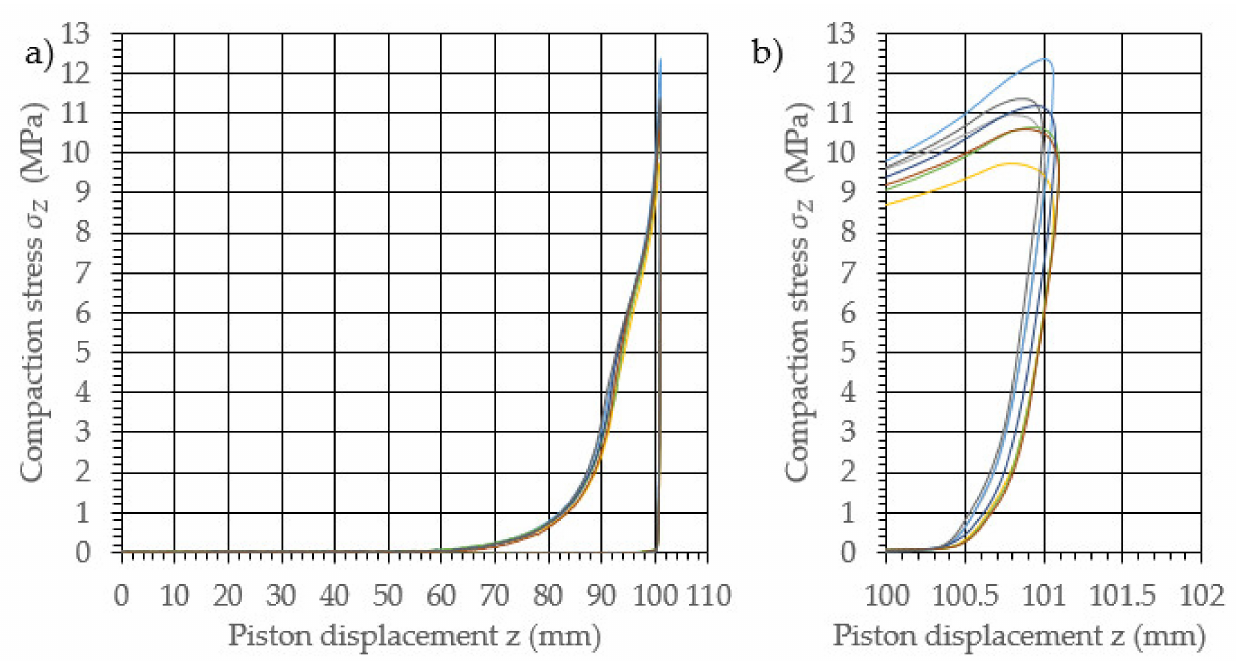
Figure 8. Characteristic curves for the compression and relaxation of dry ice with a final density of 1574.5 kg/m 3 . ( a ): The overall course of the characteristics; ( b ): an enlarged relaxation section of the compacted material.